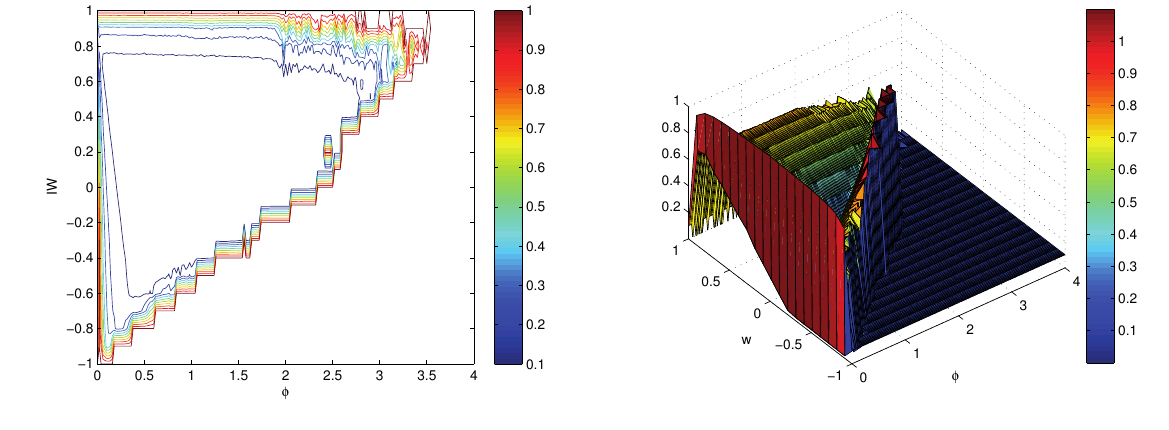
(b) Comparison with the Trelea’s result on Sphere function Figure 11: Convergence rate is mainly determined by the time-varying transfer matrix including random vari- ables r 1 and r 2 in Sphere function. Larger convergence rate naturally needs too much computational time to converge, while smaller convergence rate needs too small number of generations to converge. The major dis- crepancy landscape is between Fig. 11(a) and the right subgraph of Fig. 2 in [31] on Sphere function. In essence, both landscapes mainly result from spectral radii by di ff erent methods, where the former is calculated by the time-varying transfer matrix, while the latter is directly based on the constant transfer matrix.